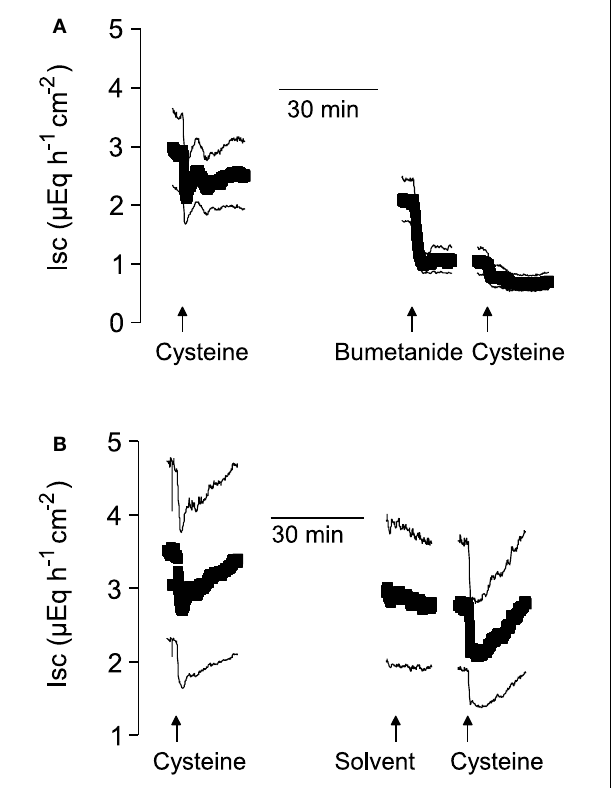
FIGURE 2 |After suppression of Cl − secretion with bumetanide, the action of cysteine is prevented. Shown are the effects of two administrations of free cysteine (5 × 10 − 3 mol · l − 1 at the serosal side; indicated by the arrows) in mucosa–submucosa preparations of rat distal colon.The line interruptions are caused by omission of current artifacts induced by washing the serosal compartment three times with five times the chamber volume, before the next administration of cysteine followed. The effect of cysteine was first tested in the absence of any inhibitors and then in the presence (A) or absence (B) of bumetanide (10 − 4 mol · l − 1 at the serosal side).The solvent for bumetanide (ethanol) was administered to the tissues which were not treated with bumetanide.Values are means (symbols) ± SEM (lines), n = 7. For statistics, see Table 2